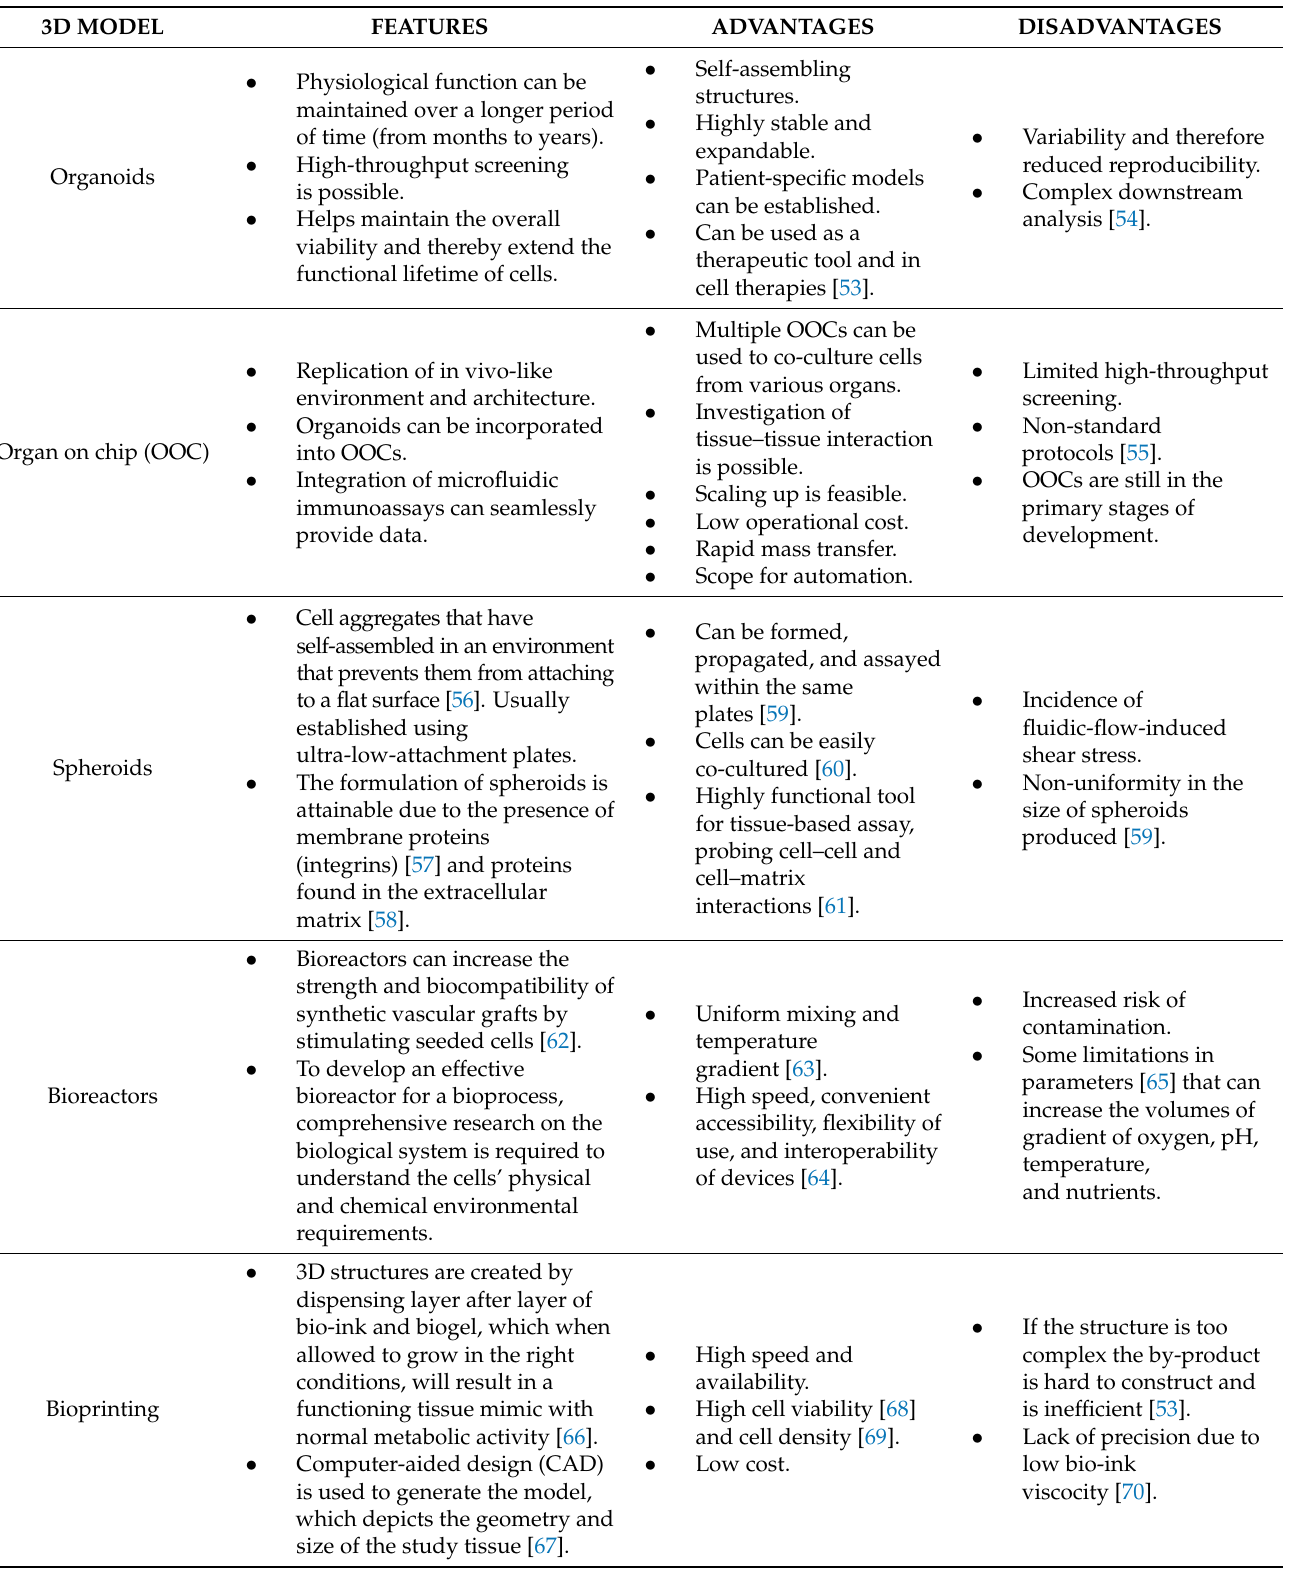
Table 2. Characteristic features of commonly used 3D culture